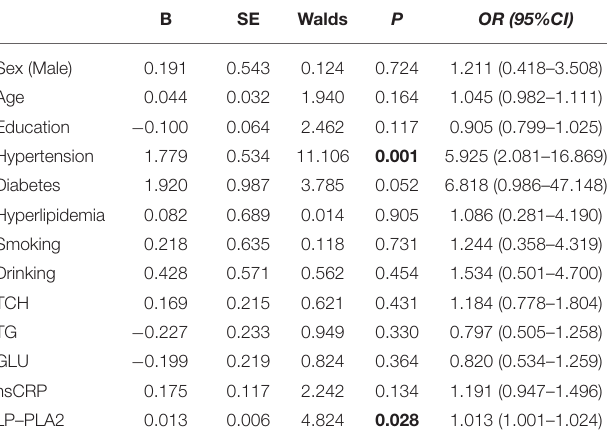
Significant differences are indicated in bold. WMHs, white matter hyperintensities; B, regression coefficient; Walds, Wald test; OR, odds ratio; TCH, total cholesterol;